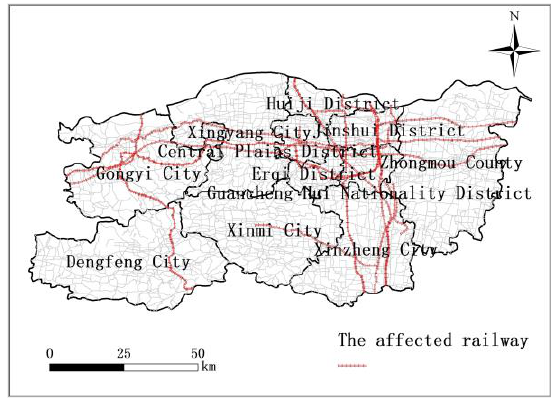
Figure 6 . Railway affected by rainstorm. Figure 6: Zhengzhou is a transportation hub in the Central Plains region of China, the railroad currently has 4 operating railroad stations, 2 railroad main lines, 6 high- speed rail lines, and 7 subway lines in operation, July 20, 2021, one of the largest passenger stations in Asia Zhengzhou station and China’s second-largest high-speed railway station Zhengzhou East Station 2 railway